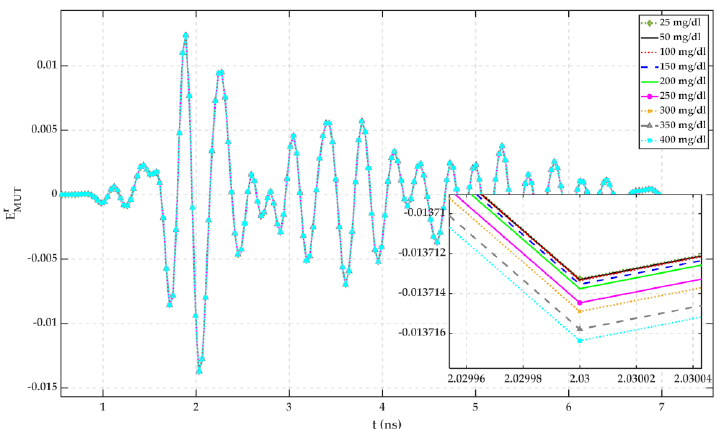
Figure 4. Simulation result for reflected signals from water with the different glucose content.